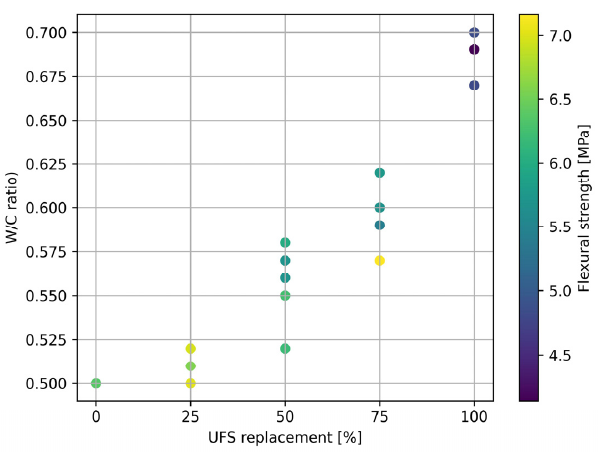
Figure 14. Flexural strength (MPa) as function of W/C ratio and UFS replacement.